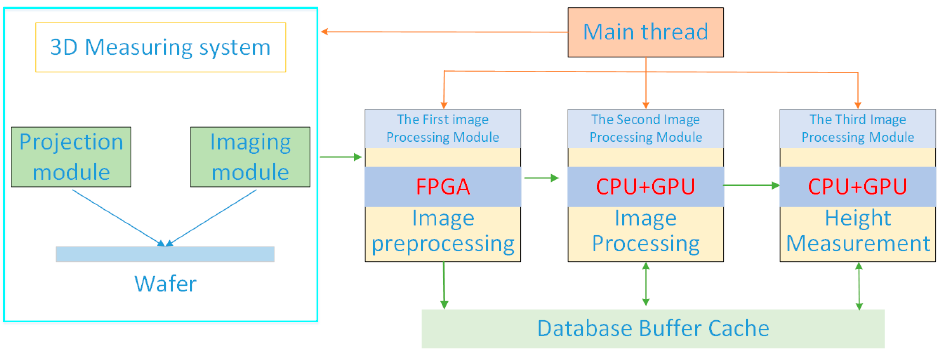
Figure 8. Image data processing flow.